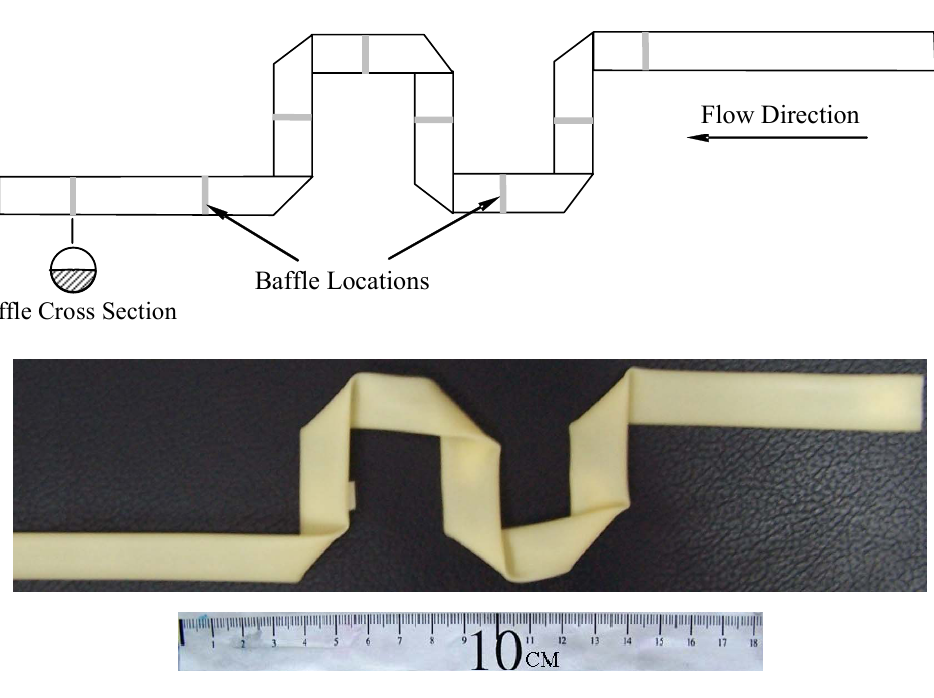
Fig. 3 Collapsed idealised compliant cystic duct